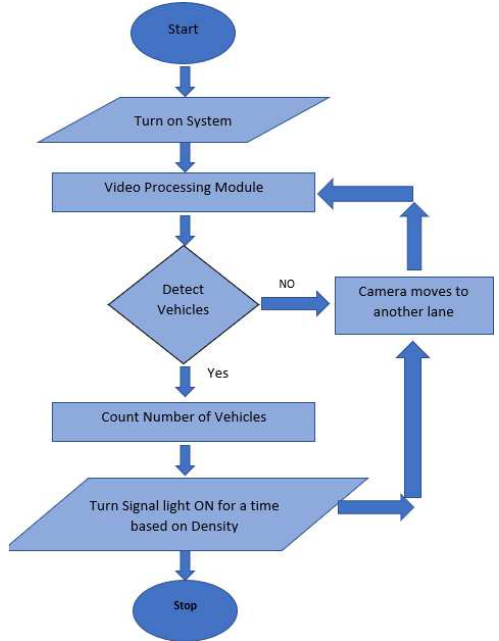
Figure 2. System Architecture